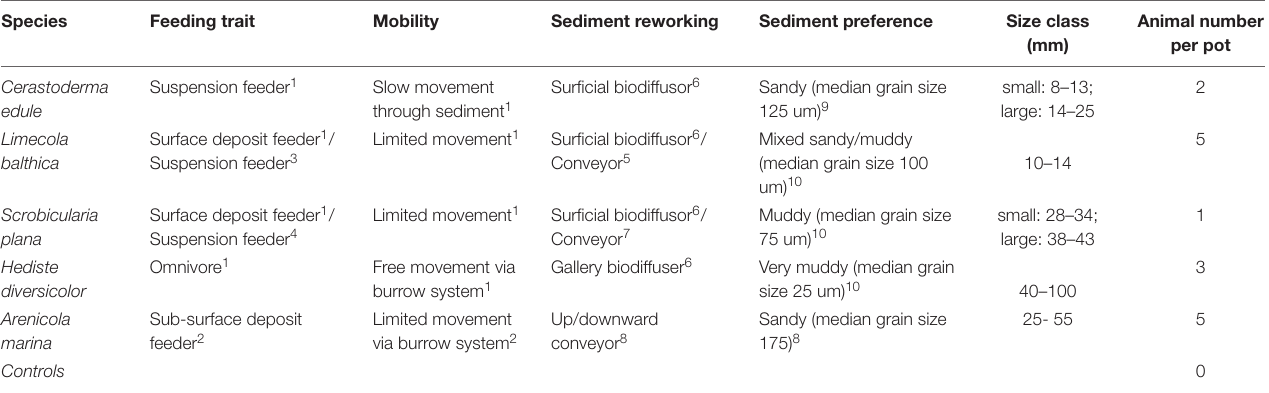
TABLE 1 | Overview of all ‘species-types’ and their traits per experimental block, including two size classes for C. edule and S. plana , plus a control treatment.